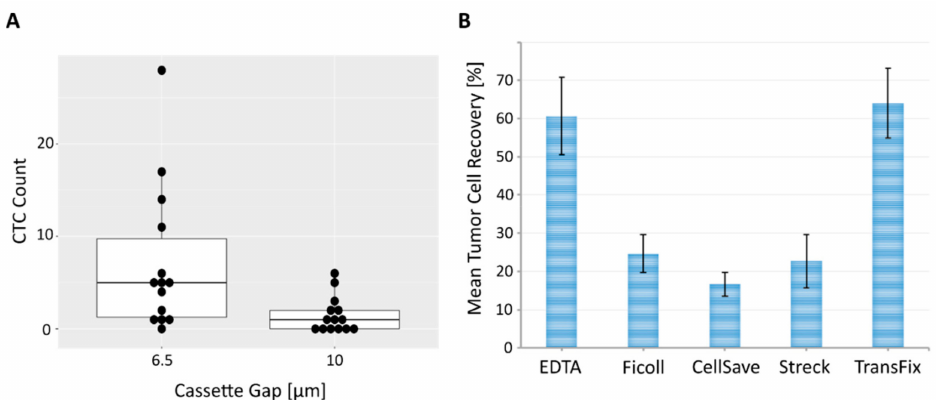
Figure 2. Performance comparison between 6.5 µ m and 10 µ m cassette gap as well as di ff erent blood